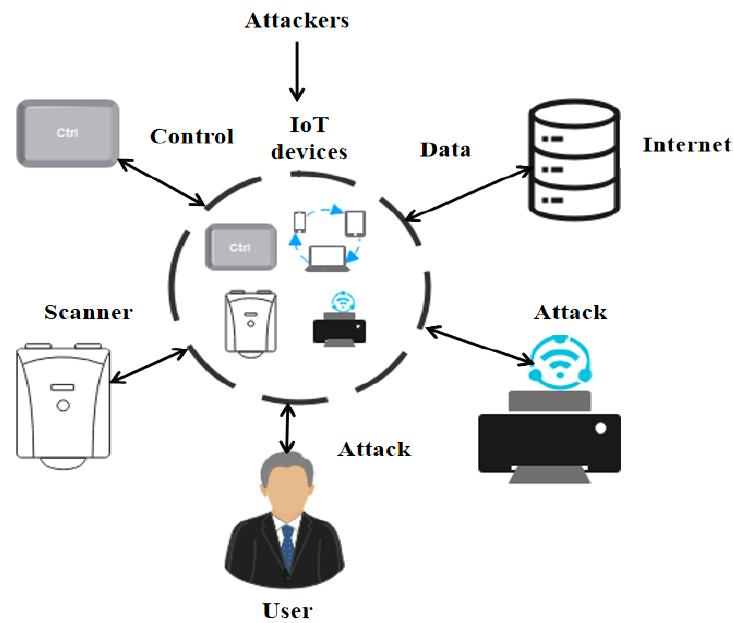
Figure 1. Pictorial Representation of attackers towards IoT devices.